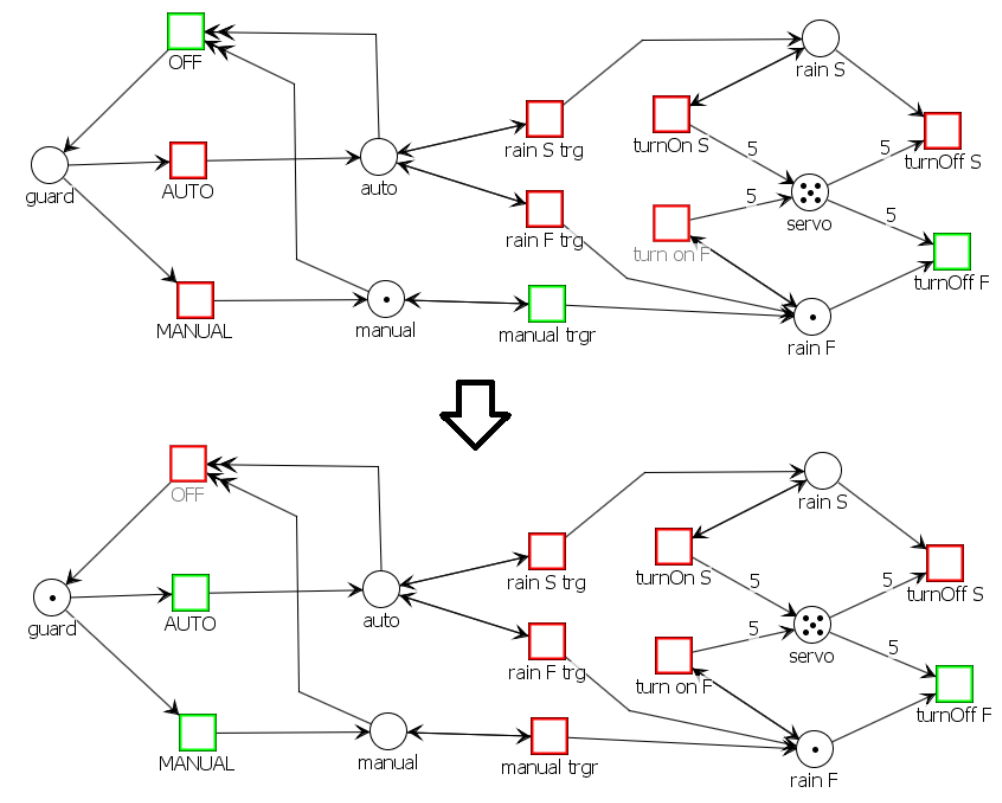
Figure 14. Petri net for control of laboratory car wiper system—turning off the manual